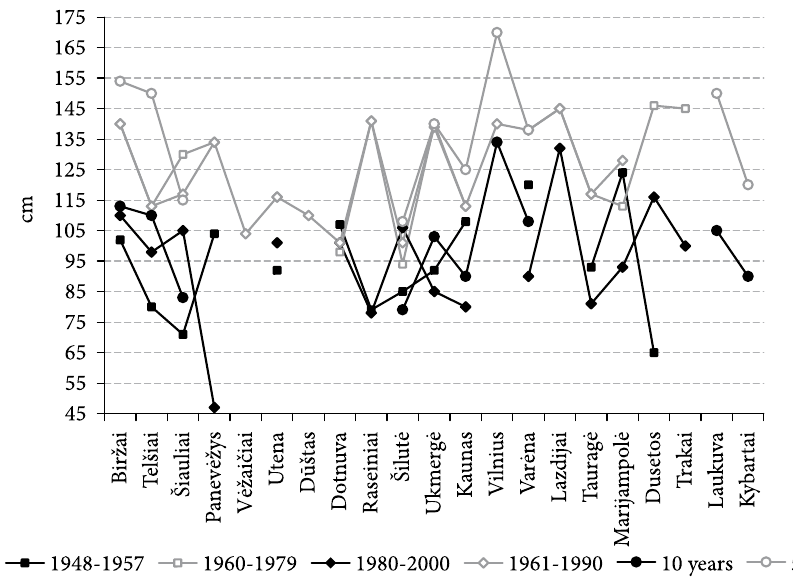
fig. 4. The largest measured depth of frozen ground indicated in different sources during various